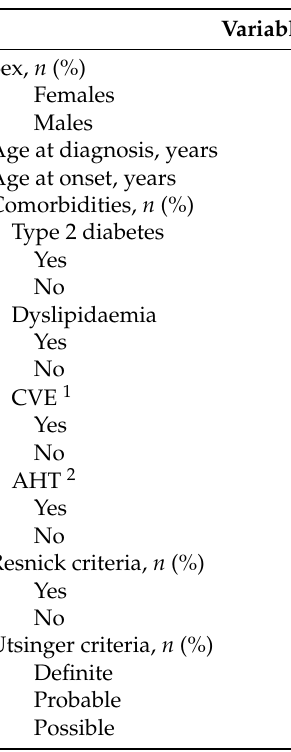
Figure 2. Flow Diagram. Legend: 1 70 patients presented exclusion criteria and were not eligible for the study. 2 SPAS: Spondyloarthropathies. 3 Other reasons: undetermined uveitis, IBD background. Table 1. Characteristics of the Study Sample ( n =